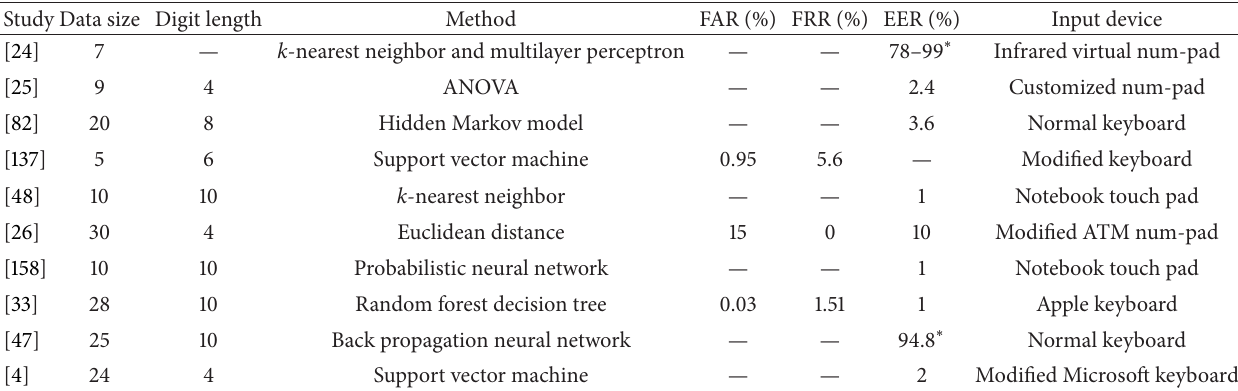
Table 9: Comparison between research works based on numerical